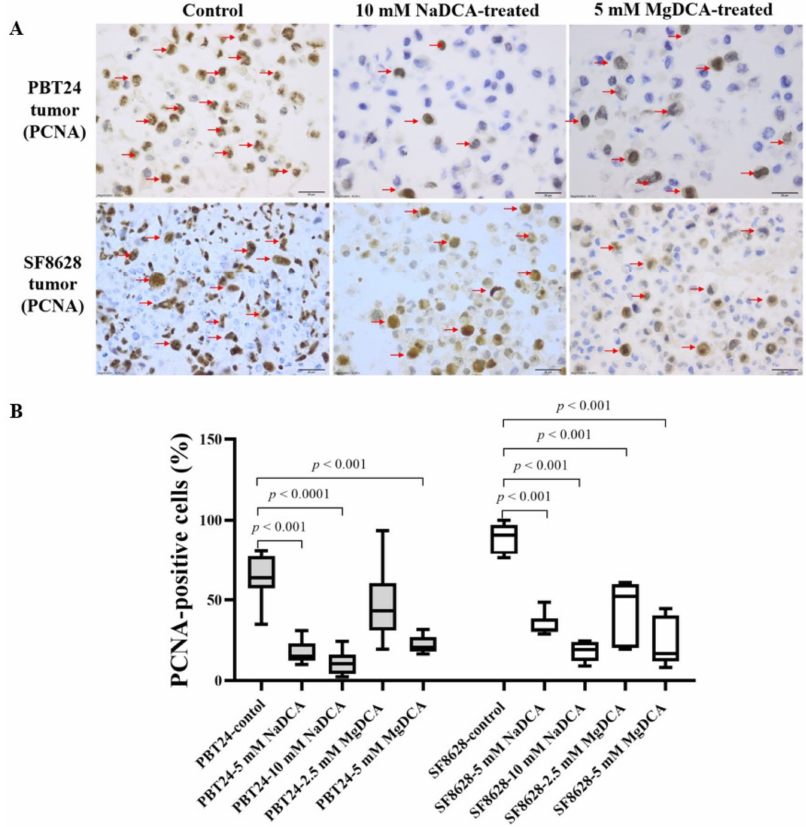
Figure 4. Immunohistochemical PCNA expression of PBT24 and SF8628 in control and DCA-treated tumor groups. ( A ) Dark brown nuclei indicate PCNA-positive cells (red arrows). The magnification is 40×, scale bar is 20 µm. ( B ) Percentage of PCNA-positive cells in the tissue of PBT24 and SF8628 tumors.